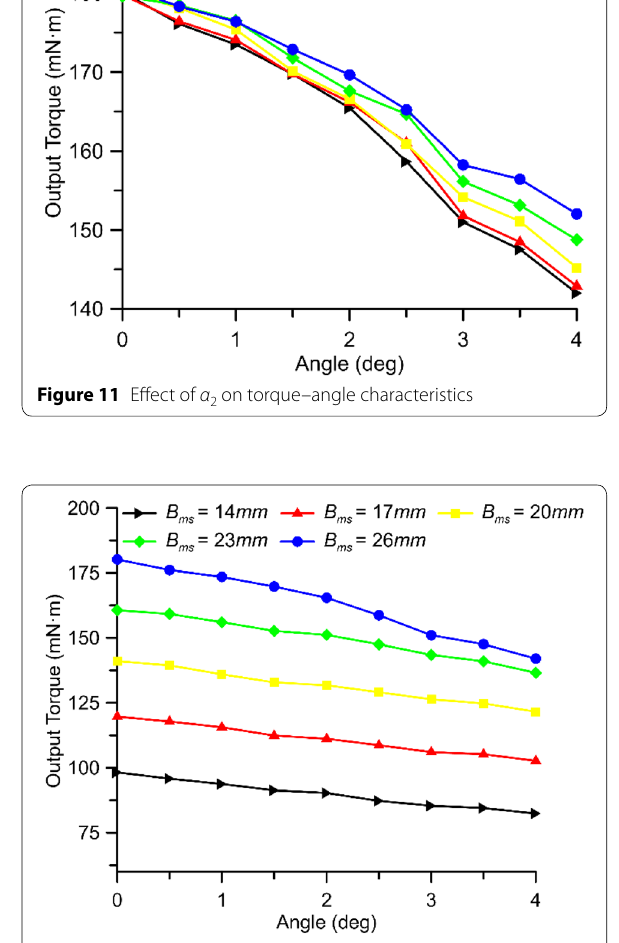
Figure 12 Effect of B ms on torque–angle